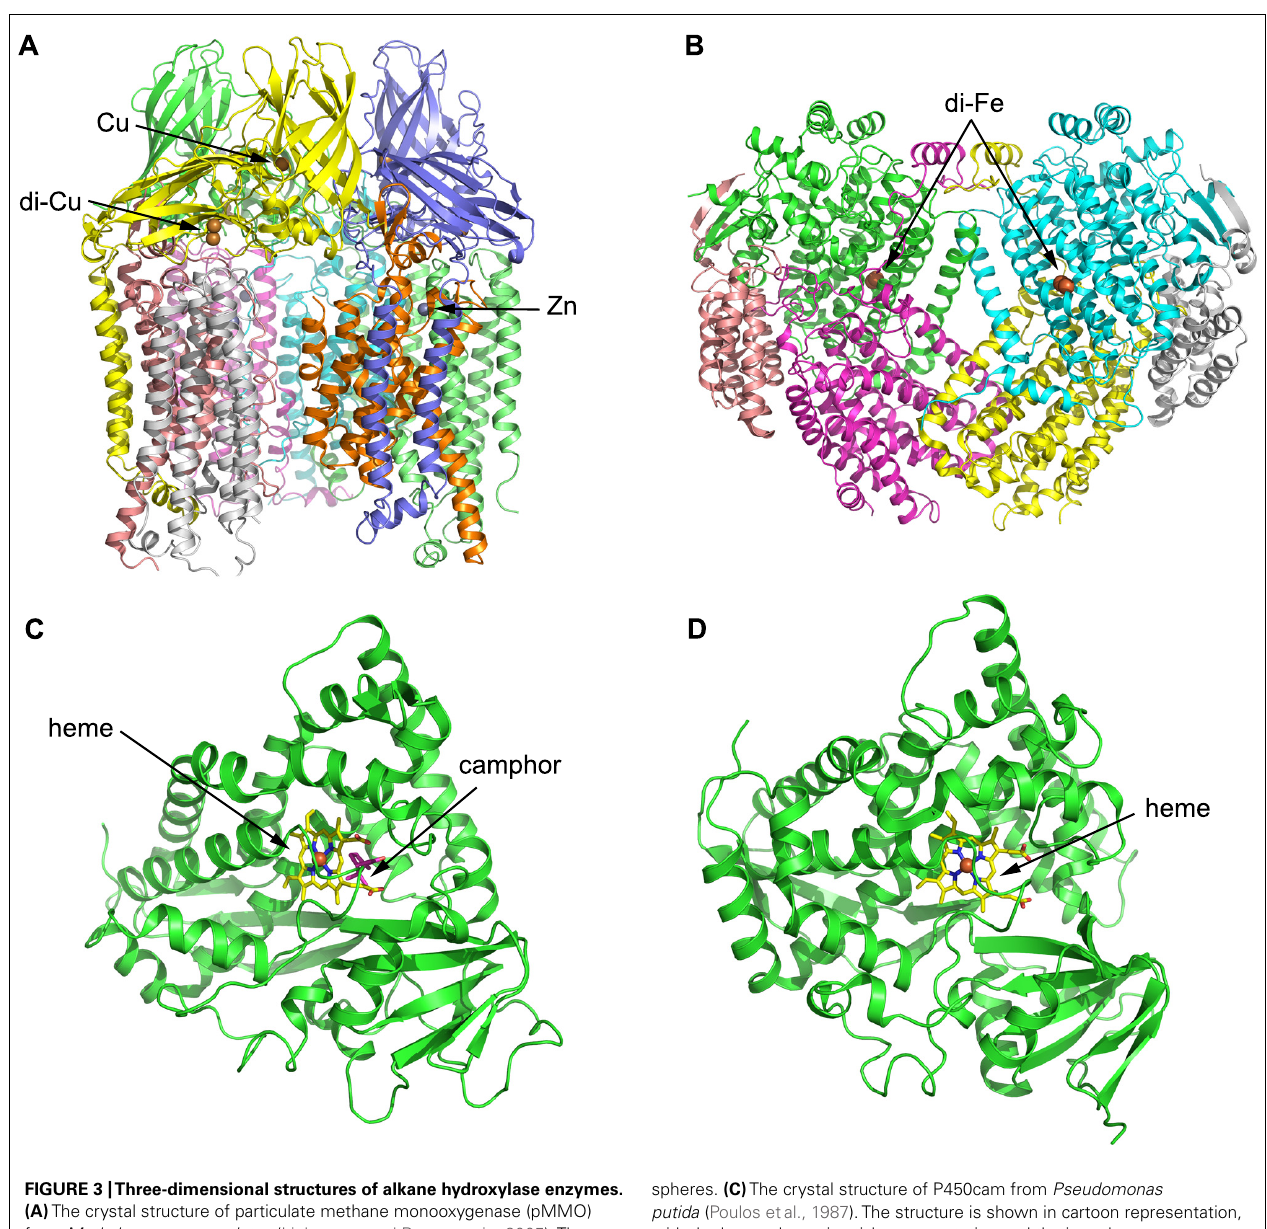
spheres. (C) The crystal structure of P450cam from Pseudomonas putida (Poulos etal., 1987).The structure is shown in cartoon representation, with the heme shown in stick representation and the iron shown as a sphere. Camphor is also shown in stick representation and colored magenta. (D) The crystal structure of P450 BM-3 from Bacillus megaterium (Ravichandran etal., 1993).The structure is shown in cartoon representation, with the heme shown in stick representation and the iron shown as a